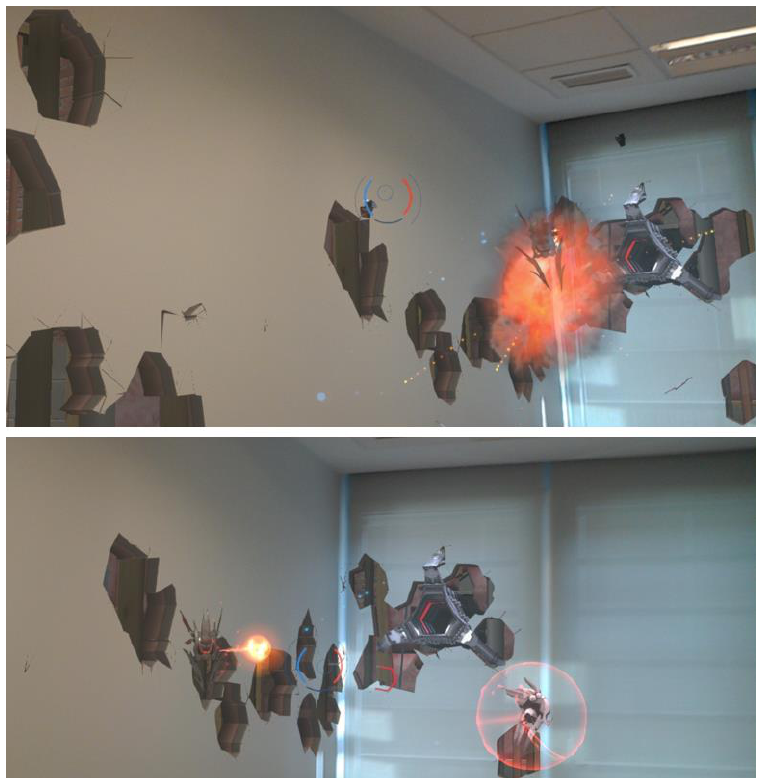
Figure 1. Screenshots of the RoboRaid software while a participant was in a session.